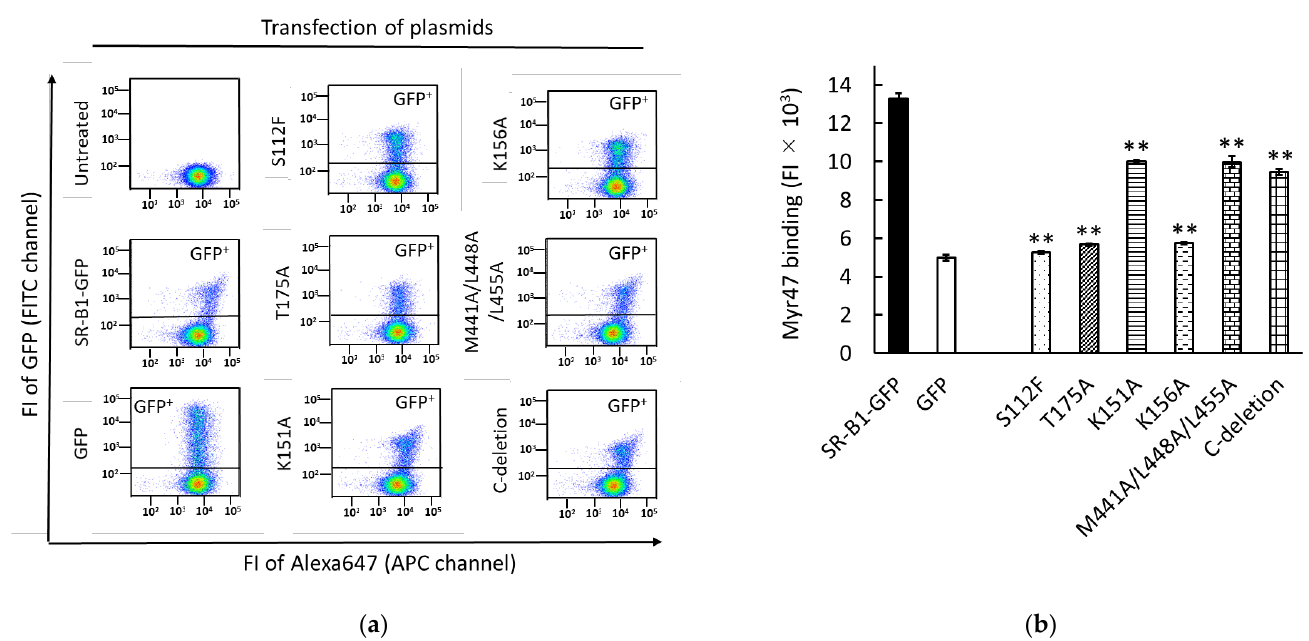
Figure 2. Effects of various mutations in SR-B1 on the binding of Myr47. HEK293T cells transfected with or without indicated plasmids were examined for the binding of Myr47. ( a ) Two-parameter dot plot analyses of Myr47 binding to GFP, SR-B1-GFP, and SR-B1-GFP mutants. HEK293T cells transfected with or without indicated expression plasmids were examined as to whether Myr47 binds to them. To obtain these plots, 30,000 cells of each sample were subjected to the analysis. Vertical and horizontal axes of plots are indicated as FI of GFP and Myr47 with flow cytometric channels used for the analyses, respectively. ( b ) Quantified ligand binding of HEK293T cells expressing GFP, SR-B1-GFP, and SR-B1-GFP mutants. Ligand binding of the upper gated area (GFP + ) in each two-parameter dot plot ( a ) was quantified. Data are expressed as means and standard errors (vertical bars) in triplicate assays. To obtain these data, 10,000 cells were applied for the analysis. Statistical analysis was carried out using Student’s t -test; ** indicates p < 0.01 when two values were compared between SR-B1-GFP and mutants.